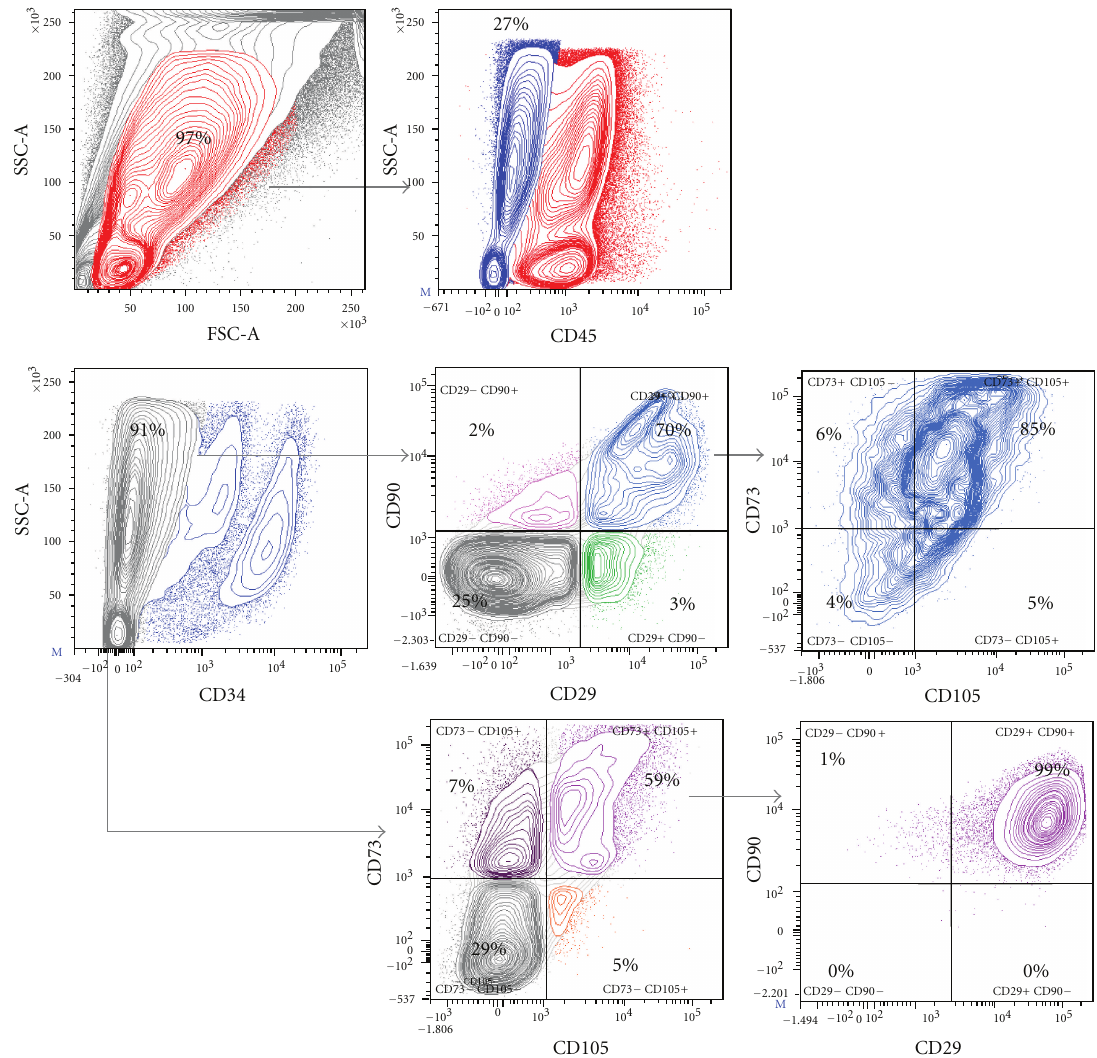
Figure 2: The Cell analysis strategy allows the isolation of 4 di ff erent cell populations. Cells were stained with mouse anti human CD45- Amcyan, CD34-FITC, CD29-APC-CY7, CD90-AF700, CD73-PE, CD105-AF647. After FSC-A/SSC-A selection, only CD45 − and CD34 − cells were considered. CD73, CD105, CD90, and CD29 profiles were then analyzed. CD73 + CD105 + cells were more than 85% to 98% positive for CD90 and CD29 (lower panel). However, CD90 + CD29 + represented a more heterogenous population when looking at CD73, CD105 stainings. We defined di ff erent cell populations based on CD90 and CD29 subpopulation: CD90 + CD29 + ; CD90 − CD29 + ; CD90 + CD29 − ; CD90 − CD29 − (middle